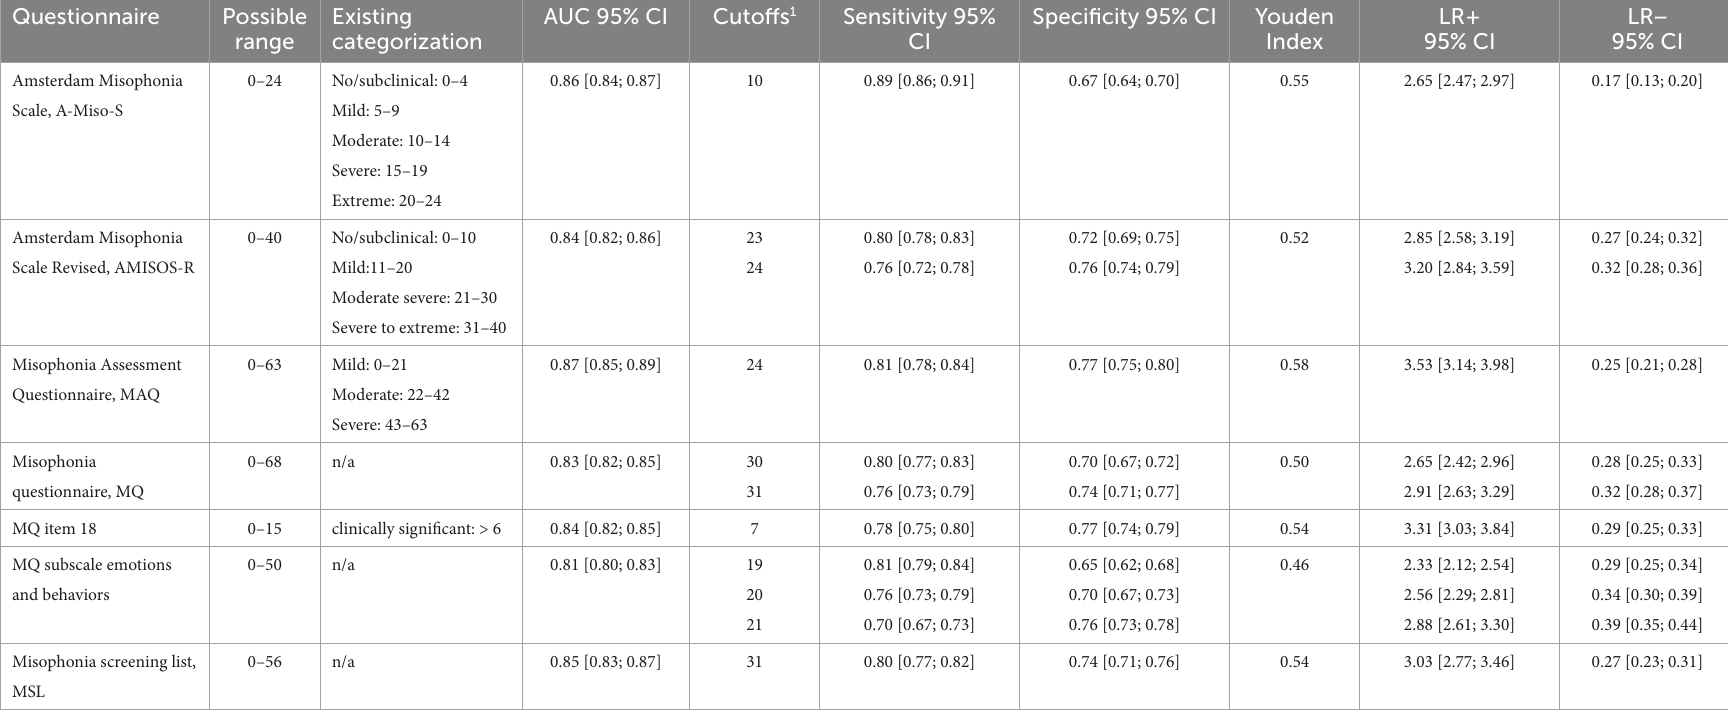
TABLE 5 Area under the curve (AUC) and suggested cutoffs based on functional impairment due to misophonia symptoms. Questionnaire Possible